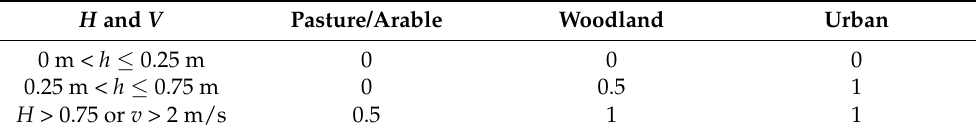
Table 1. Debris factors from water flood depths, velocities, and land-uses. H and V Pasture/Arable Woodland Urban